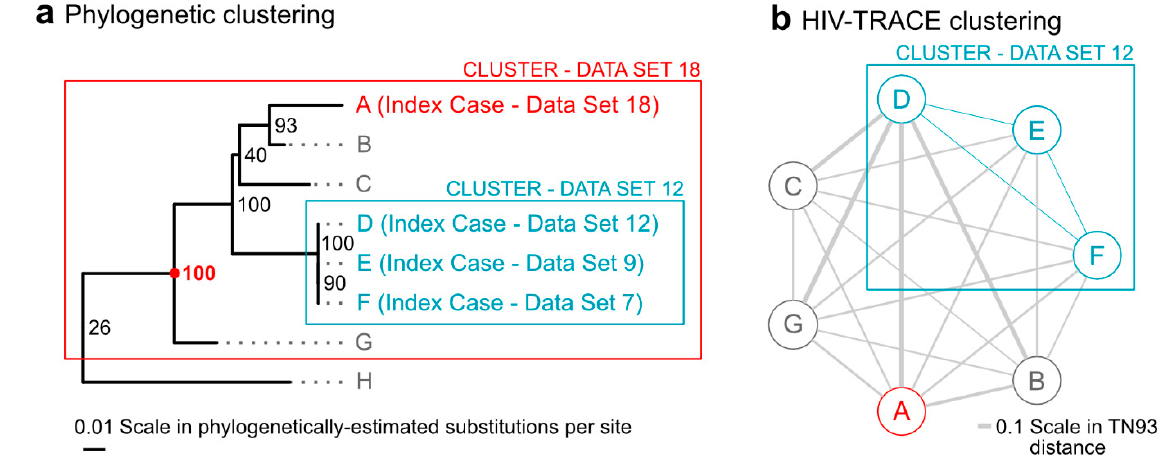
Figure 2. Title: A growing cluster with differential detection between phylogenetic and distance-only methods. Legend: The figure shows a comparison between a phylogenetic cluster (panel ( a )) and a HIV-TRACE cluster graph (panel ( b )) for those same cases. The 100% bootstrap supported (red 100) cluster in panel a (red box) contains a new index case from dataset 18 (A, red); three prior index cases from datasets 7, 9, and 12 (D–F, blue), which formed a cluster in the analysis of dataset 12 by both phylogenetic methods and HIV-TRACE at the 0.5% threshold; and previously un-clustered cases B, C, and G. Panel ( a ) also shows the nearest non-clustered case (H). The HIV-TRACE distance-based cluster graph in panel ( b ) of the same cases demonstrates that only cases D, E, and F remain part of the cluster in dataset 18 (blue edges). Cases A, B, C, and G are not clustered by HIV-TRACE as their pairwise distances (gray edges) are larger than distance thresholds established by the Centers for Disease Control and Prevention (CDC). Notes : Branch lengths in ( a ) are scaled by the estimated substitutions per site in the phylogeny, while edge thicknesses in ( b ) are scaled by the TN93 pairwise genetic distance calculated by HIV-TRACE. Phylogenetic bootstrap support (out of 100 bootstrap replicates) is shown in small text next to splits in the tree in ( a ) and the split with bootstrap support of 100 that defines the cluster is highlighted with a red dot.